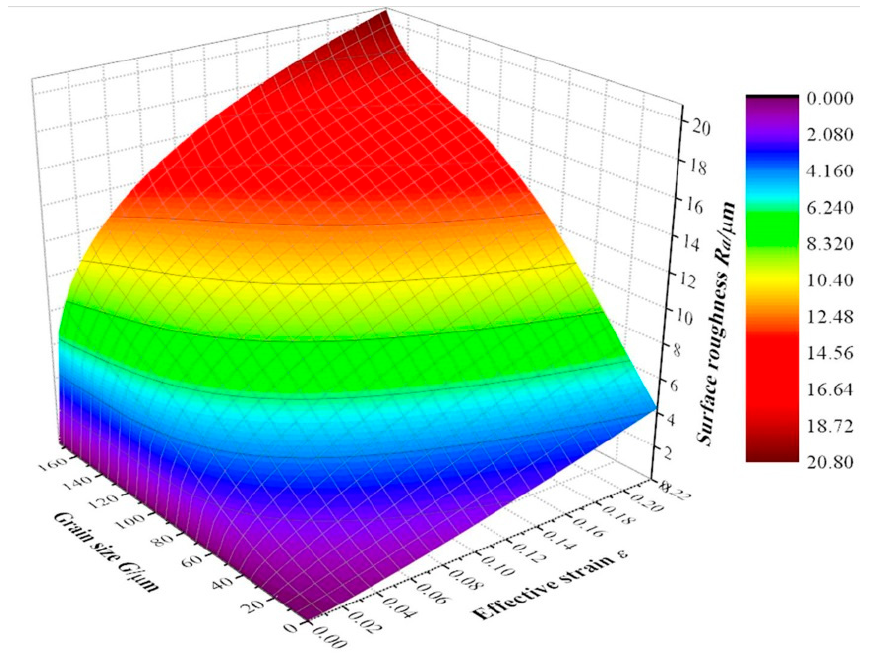
Figure 12. Curve surface showing the relation between surface roughness R a , grain size G and effective strain ε .